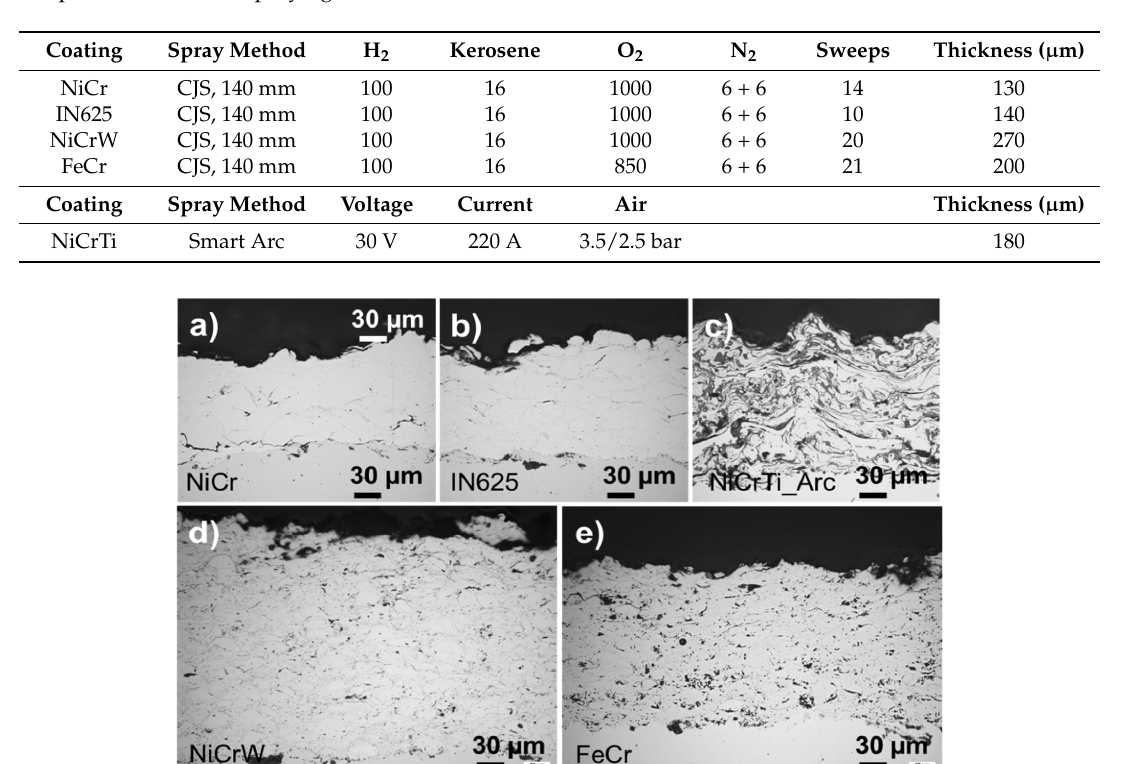
Figure 1. Optical micrographs of the thermal spray coatings before testing: ( a ) HVOF sprayed NiCr and ( b ) IN625; ( c ) arc sprayed NiCrTi; ( d ) HVOF sprayed NiCrW and ( e ) FeCr.